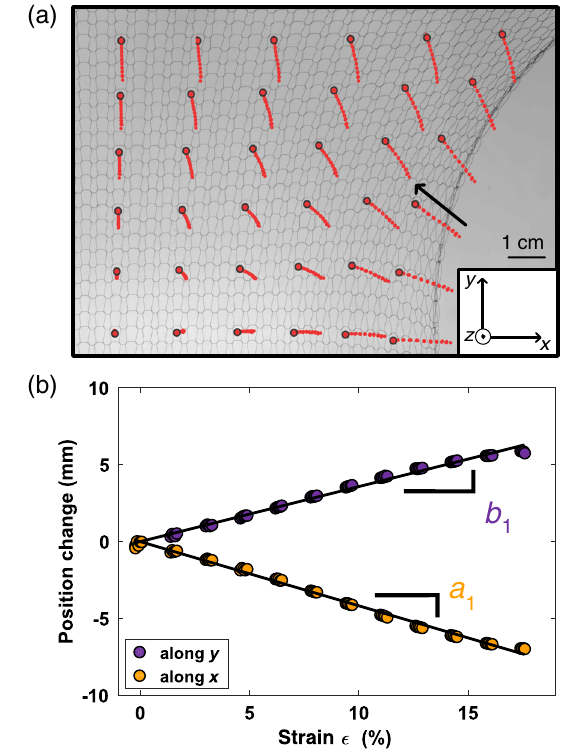
FIG. 2. The trajectories of the stitches are tracked while the fabric is stretched. (a) Picture of the upper-right part of the fabric for ε ¼ 18% , referred to as the actual configuration. Red dots represent the paths of a selection of stitch centroids when the strain ε is varied from 0 to 18% during the stretching phase of the 5 cycles (Movie S2 in Supplemental Material Ref. [24] shows the corresponding trajectories). Black circles show the corresponding positions in the actual configuration. (b) Plot of the projections of the change in position of the stitch ’ s centroid next to the black arrow along the x (wale) and y (course) directions as a function of the applied strain during the stretching phases. Black solid lines represent the best linear fit, whose slopes are measures of a 1 and b 1